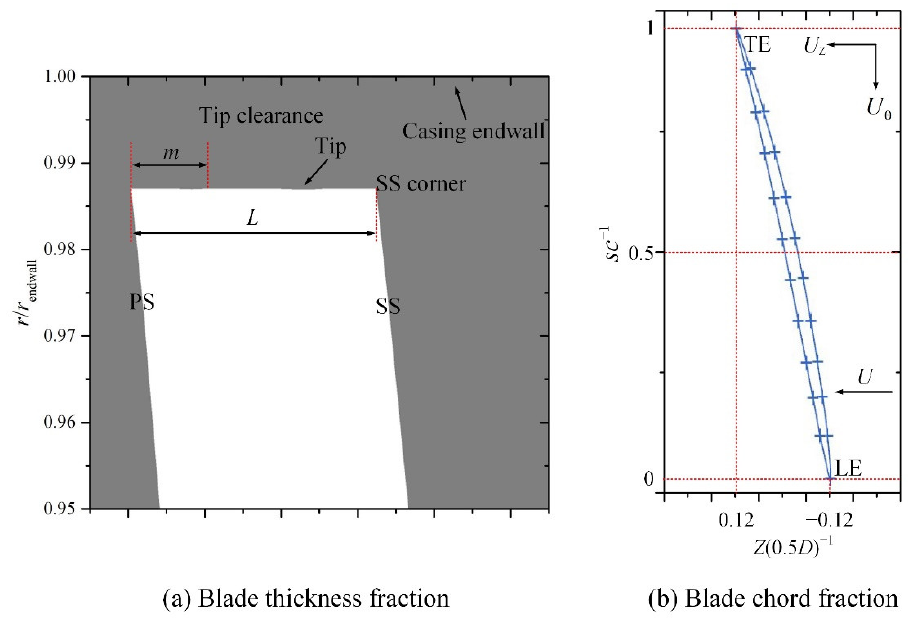
Figure 5. Geometric parameters in the tip clearance. ( a ) Blade thickness fraction; ( b ) Blade chord fraction.